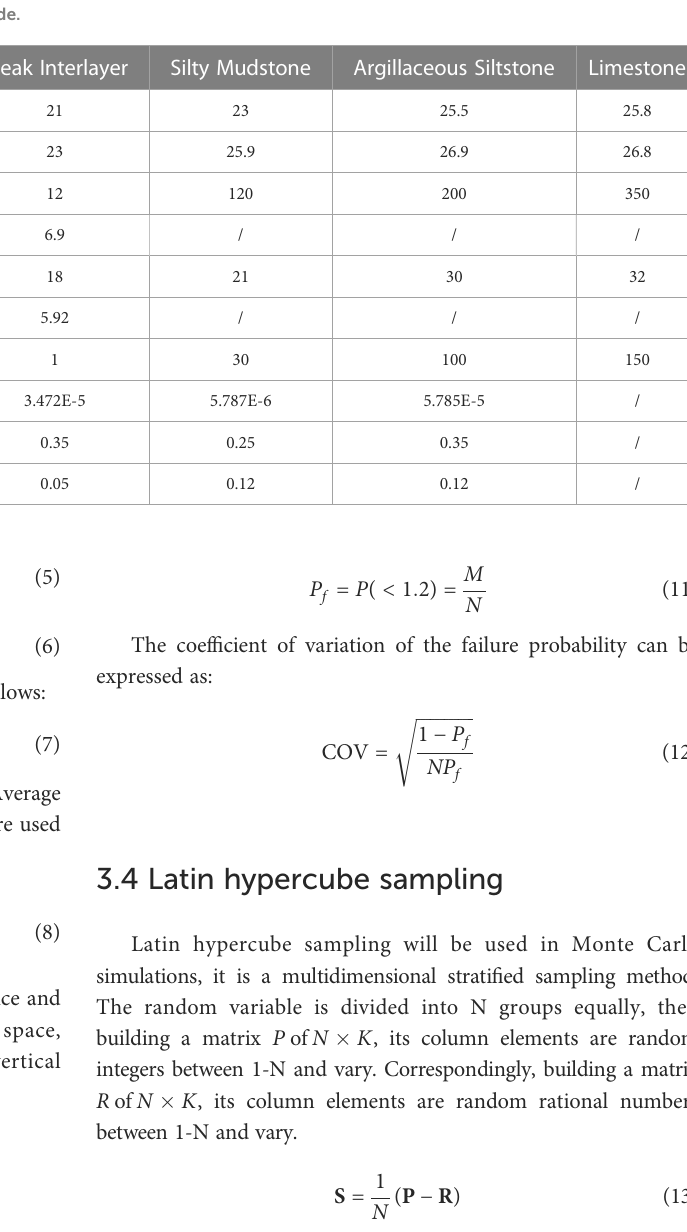
TABLE 1 Parameters of rock and soil mass of Zhaoshuling